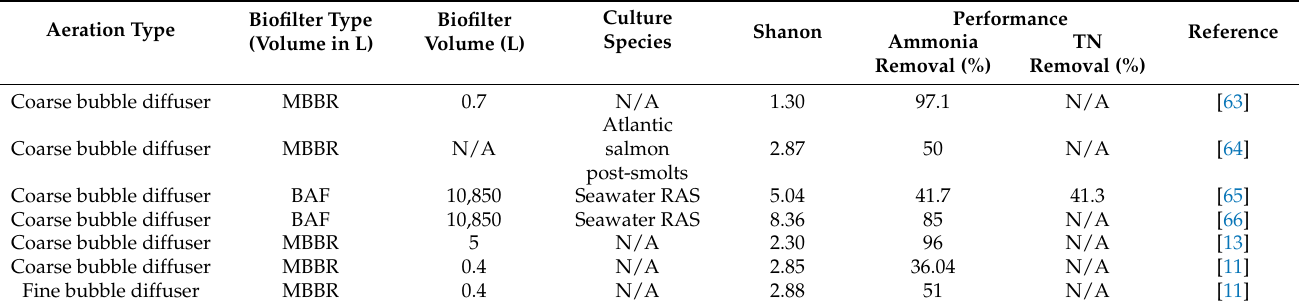
Table 3. Summary of microbial community in